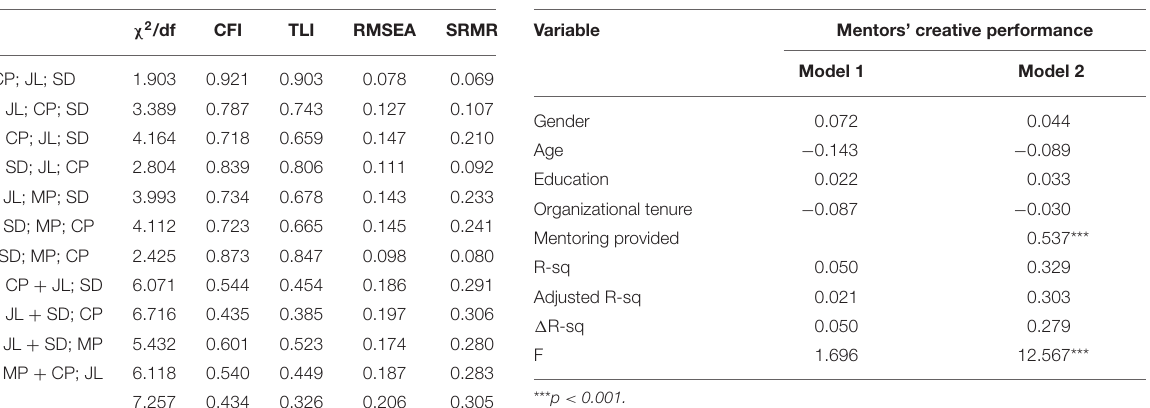
TABLE 3 | Hierarchical regression